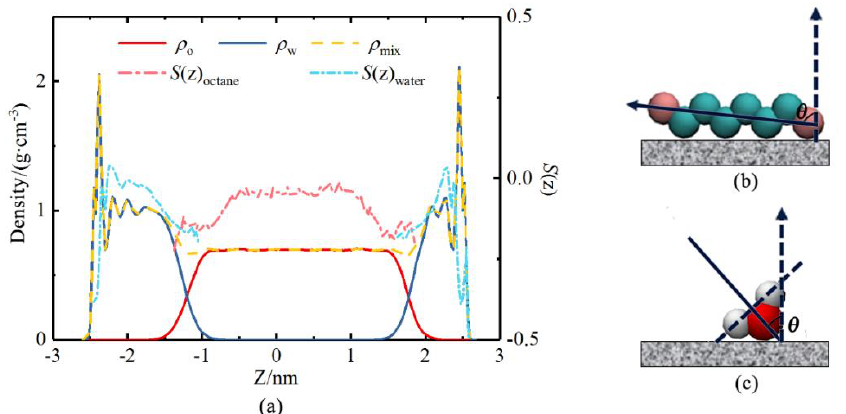
Figure 4. ( a ) The density profiles and orientation order parameter distribution of oil and water in quartz nanopore; the schematic diagram of angle θ of ( b ) long − chain alkane and ( c ) water